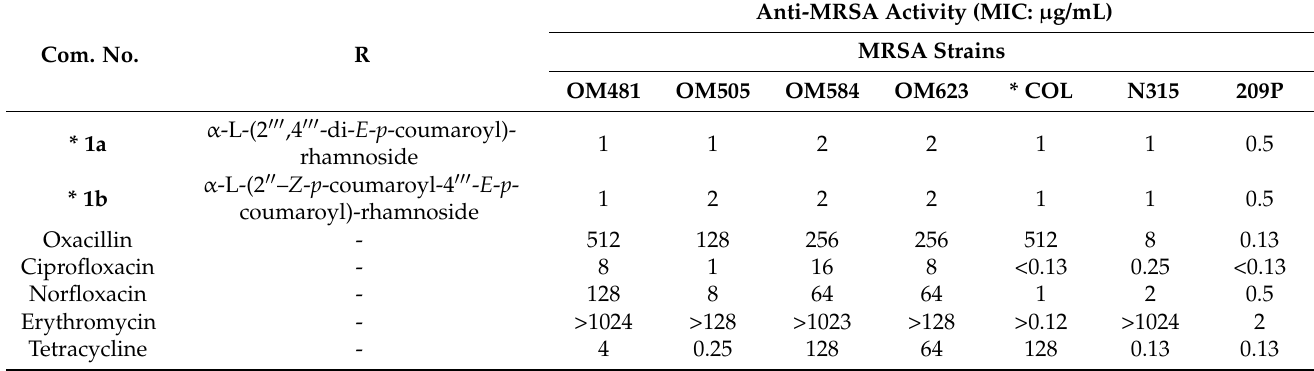
Table 1. Isolated compounds from Laurus nobilis were shown to demonstrate potent antibacterial activity against MRSA strains.